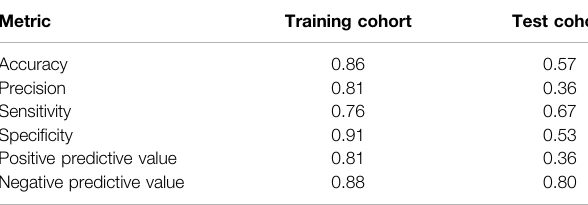
TABLE 5 | Performance of the ridge regression model.